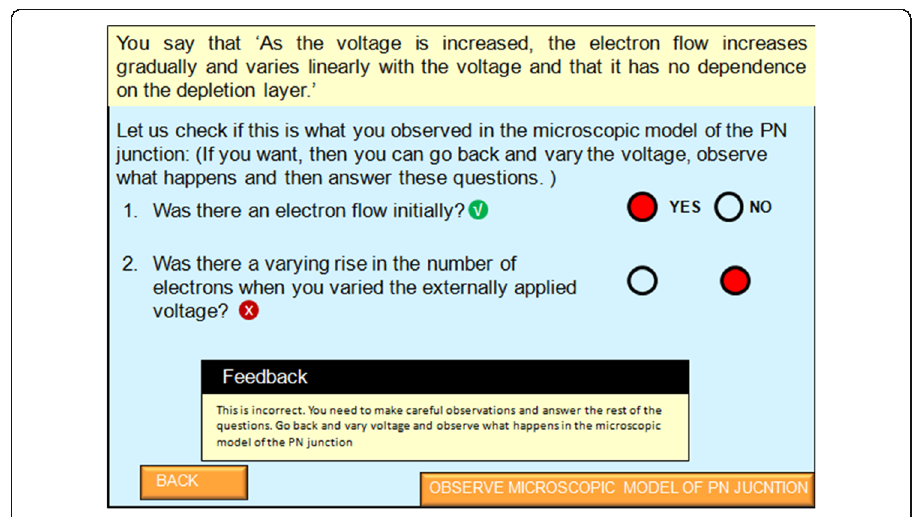
Fig. 7 Assertion and reasoning questions with customized